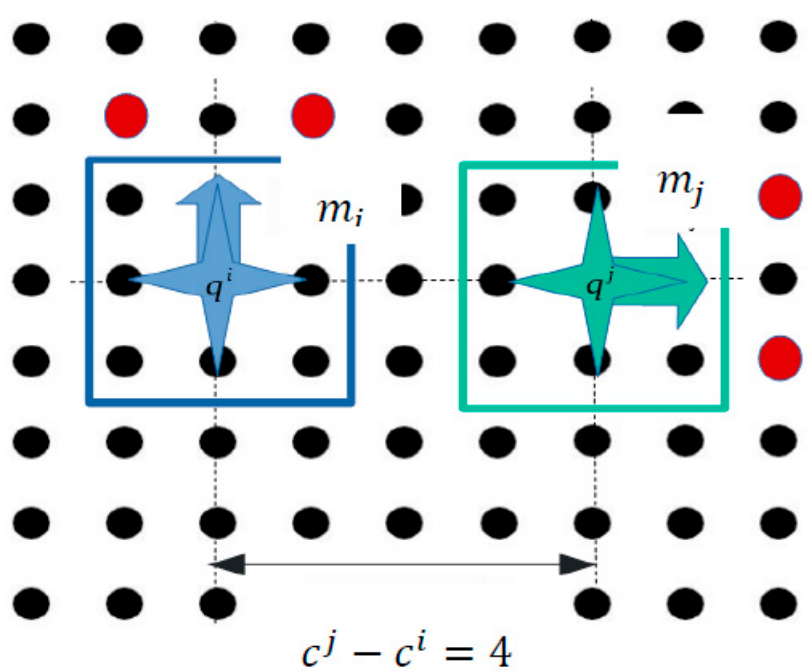
Figure 21. Constraints for the parallel motion of two microparts which diverge the one from the other.